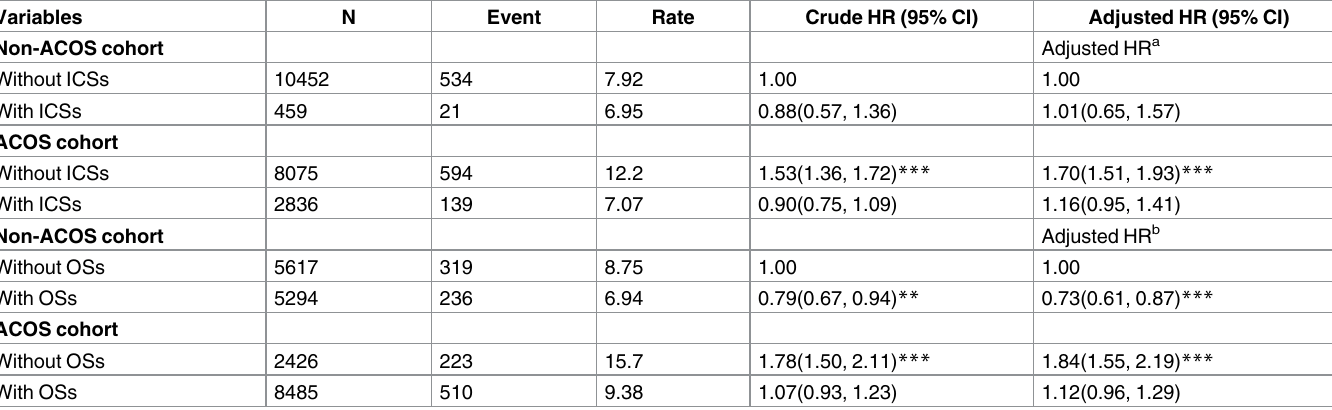
Table 3. Adjusted hazard ratio for depression in the ACOS patients with and without ICSs and OSs use during the follow-up